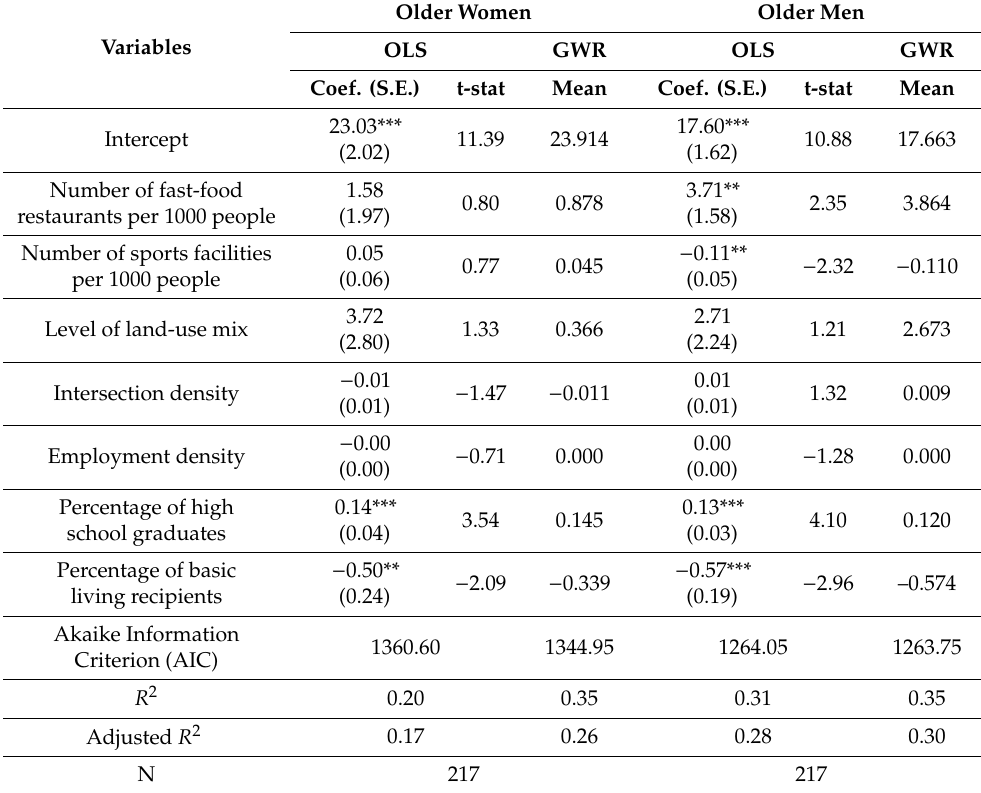
Table 2. Summary statistics of local coe ffi cients in geographically weighted regression (GWR) for older women and